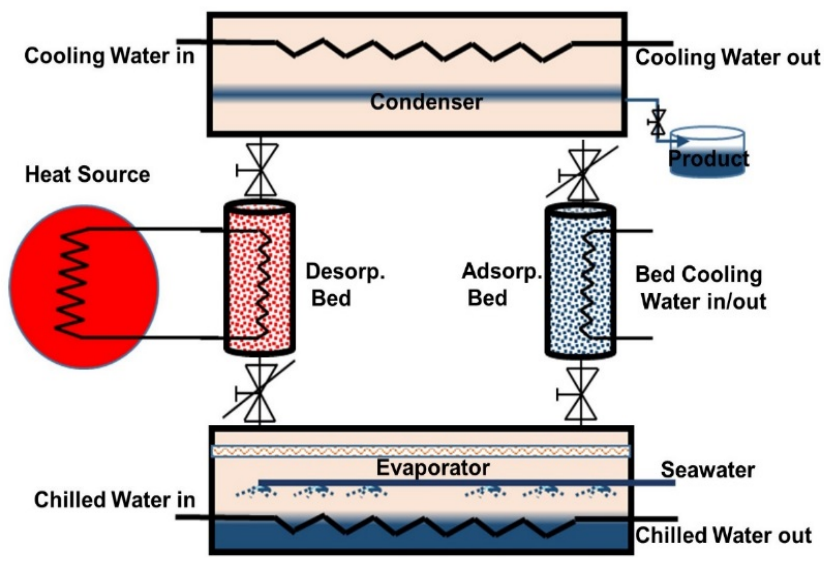
Figure 11. ADD standard configuration.